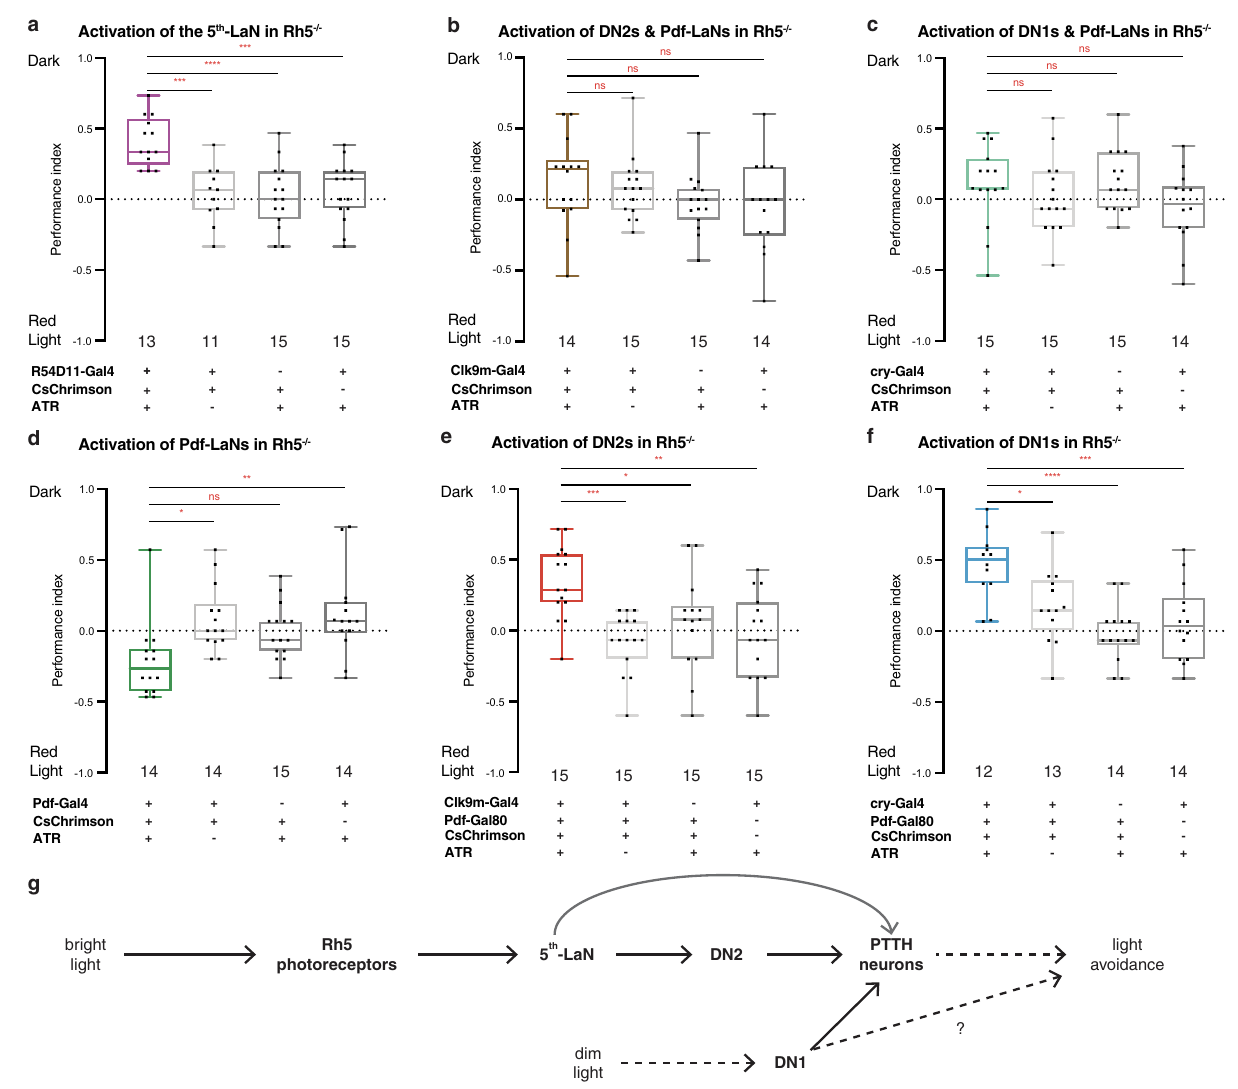
Fig. 4 | Activation of the 5th-LaN, DN2s or DN1s rescues the light avoidance defect exhibited by Rh5 mutant larvae. a – f Rescue of the light avoidance defect of Rh5 mutant larvae via CsChrimson mediated activation of speci fi c subsets of clock neurons. Activation of the 5th-LaN ( a ), DN2s ( e ) or DN1s ( f ) results in light avoidance. Activation of Pdf-LaNs results in light preference ( d ). No effect is observedwhenPdf-LaNsareactivatedalongsideDN2s( b )orDN1s( c ).ATR:all- trans retinal.Boxplotsindicatemedian(middleline),25thand75thpercentile(box),bars represent maximum and minimum. One-way ANOVA, ns: not signi fi cant, * p <0.05,